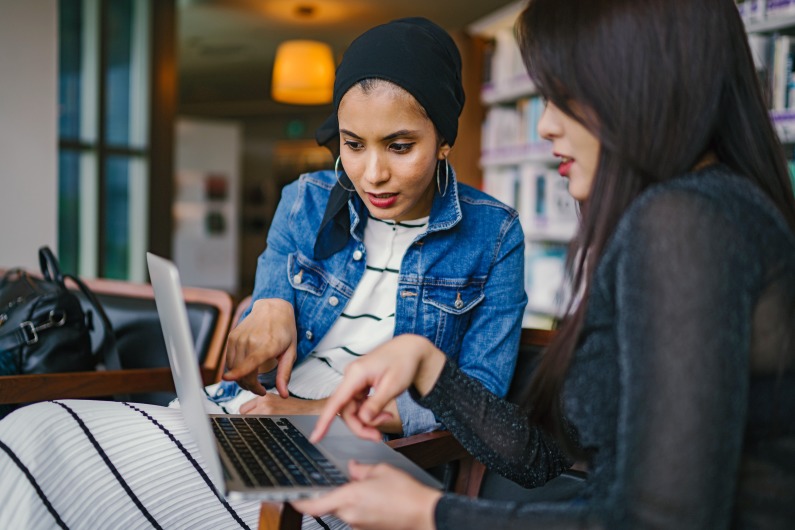
Photo: Two students and young professionals engaging in discussion while pointing to a laptop (by mentatdgt, used with permission from Pexels.com).